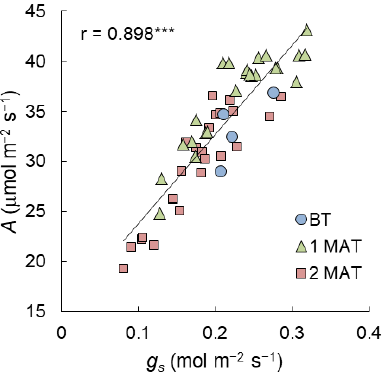
Figure 3. Relationship between g s and A at each stage (before treatment, BT; one month after treatment, 1 MAT; 2 months after treatment, 2 MAT) in Exp. 1. The linear trendline and r value for the overall samples are shown in the graph. *** denotes significance at the 0.1% level. Table 1. E ff ects of NaCl levels in irrigation water on chlorophyll fluorescence parameters in Exp. 1. The saline irrigation water treatments also tended to decrease some fluorescence parameters.